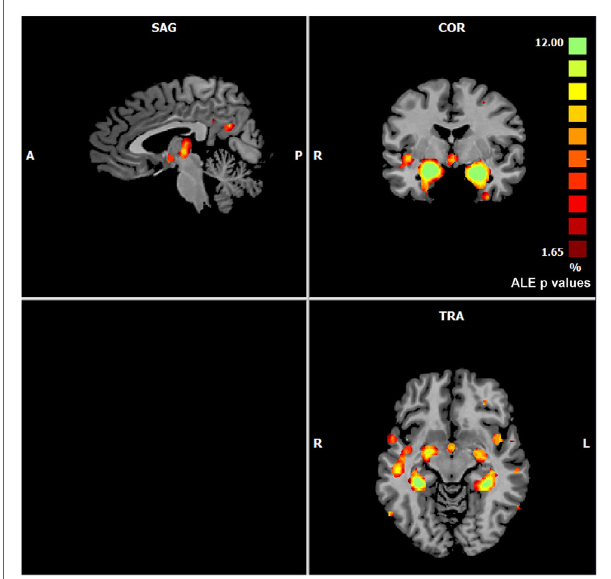
FigUre 1 | Gray matter anatomical likelihood estimation (ALE) results. The image summarizes the results of all the experiments considered in this meta-analysis. Colors from red to green show gray matter decreases [ALE maps were thresholded using voxel-level FWD p < 0.05 (104) and visualized using Brainvoyager